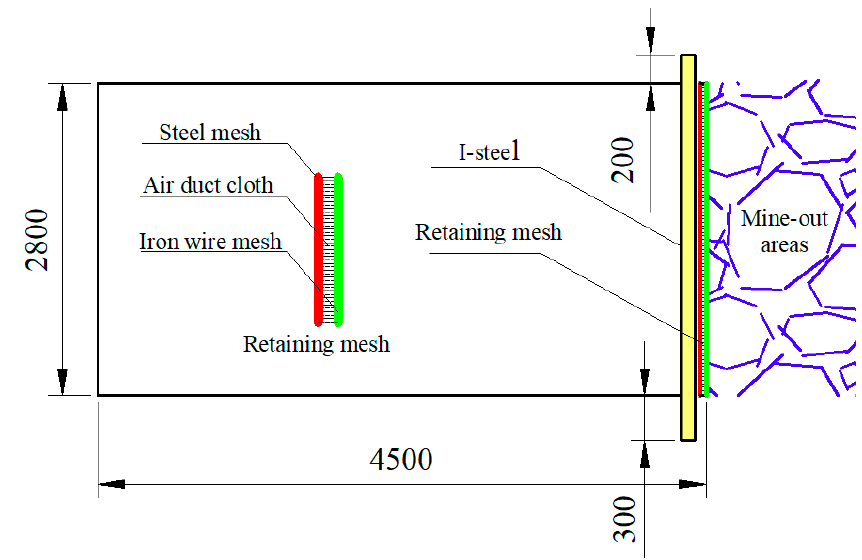
Figure 13. Retaining gangue support schematic diagram.